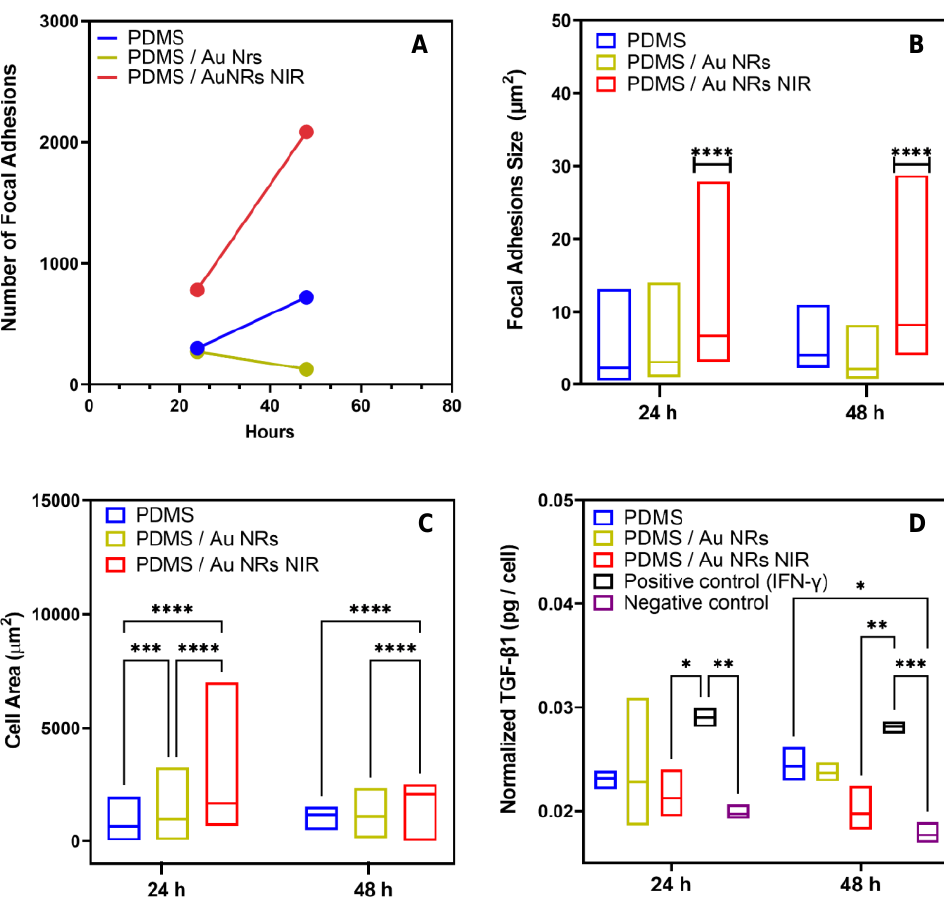
Figure A5. Number ( A ) and size ( B ) of FAs at 24 and 48 h. Cell area ( C ) and normalised TGF- β 1 secretion ( D ) after 24 and 48 h. Two-way ANOVA, post hoc Tukey’s test, * p ≤ 0.05, ** p ≤ 0.01, *** p ≤ 0.0003, **** p ≤ 0.0001.